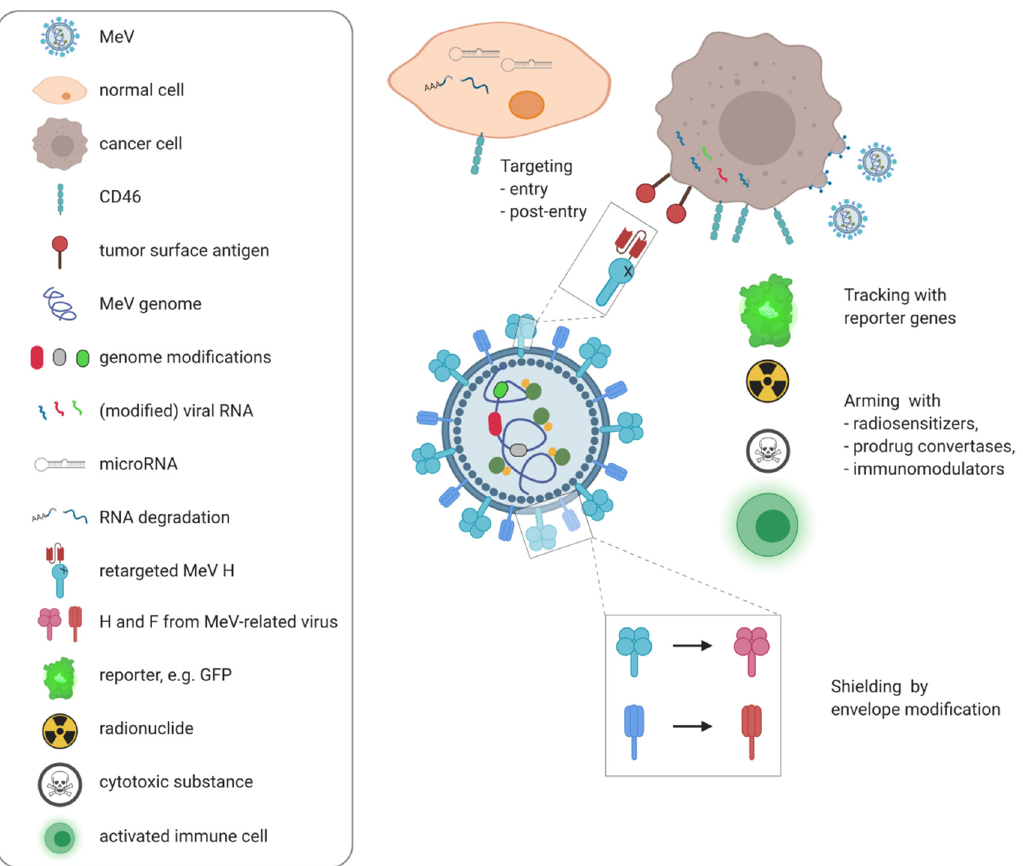
Figure 3. Engineering of oncolytic measles virus. Top: Targeting for increased tumor specificity can be achieved on the entry or post-entry level. For entry targeting, the viral attachment protein H can be mutated to ablate natural tropism and redirected by fusing targeting moieties such as antibody single-chain variable fragments to H (red). Post-entry targeting is achieved via target sites for microRNAs (gray) introduced into viral genes which are differentially expressed in malignant compared to healthy tissues, leading to degradation of the respective viral RNAs in normal cells. Middle: Viruses equipped with reporter genes encoding, e.g., fluorescent proteins (light green) can be used to track viral spread. To increase therapeutic efficacy, viruses can be armed with additional genes encoding radiosensitizers, prodrug convertases, or immunomodulators. Bottom: Shielding against neutralizing antibodies can be achieved by exchanging the viral envelope proteins for the counterparts from a related virus.